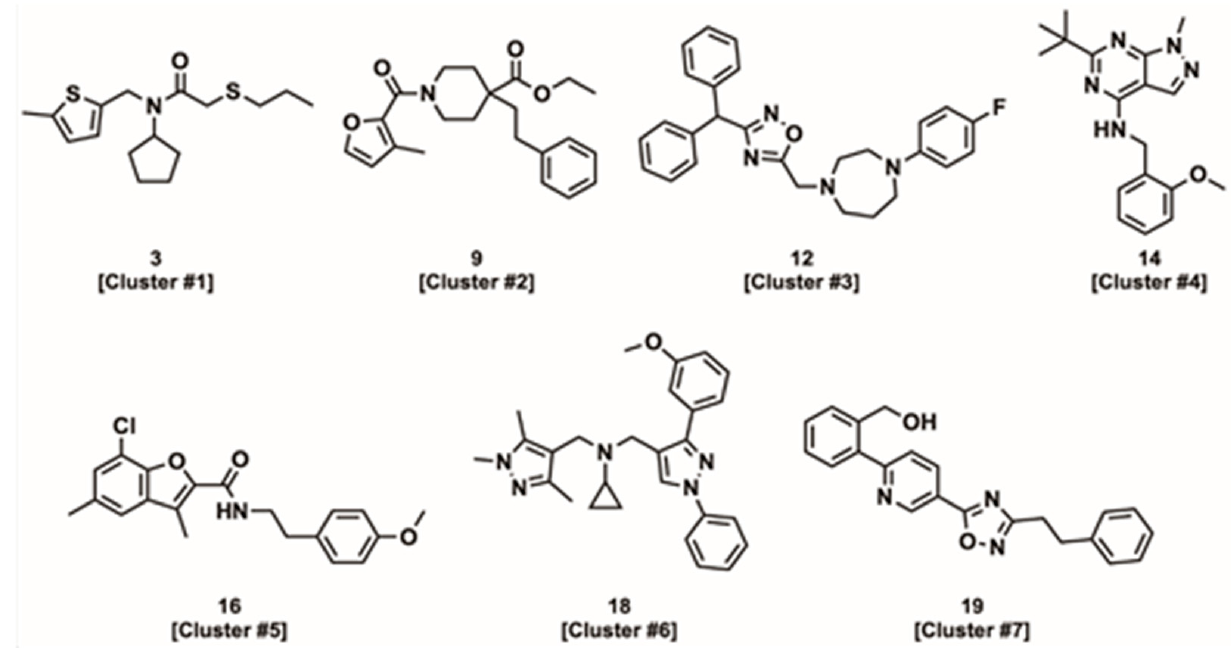
Figure 3. Representative chemical structures from each cluster set.